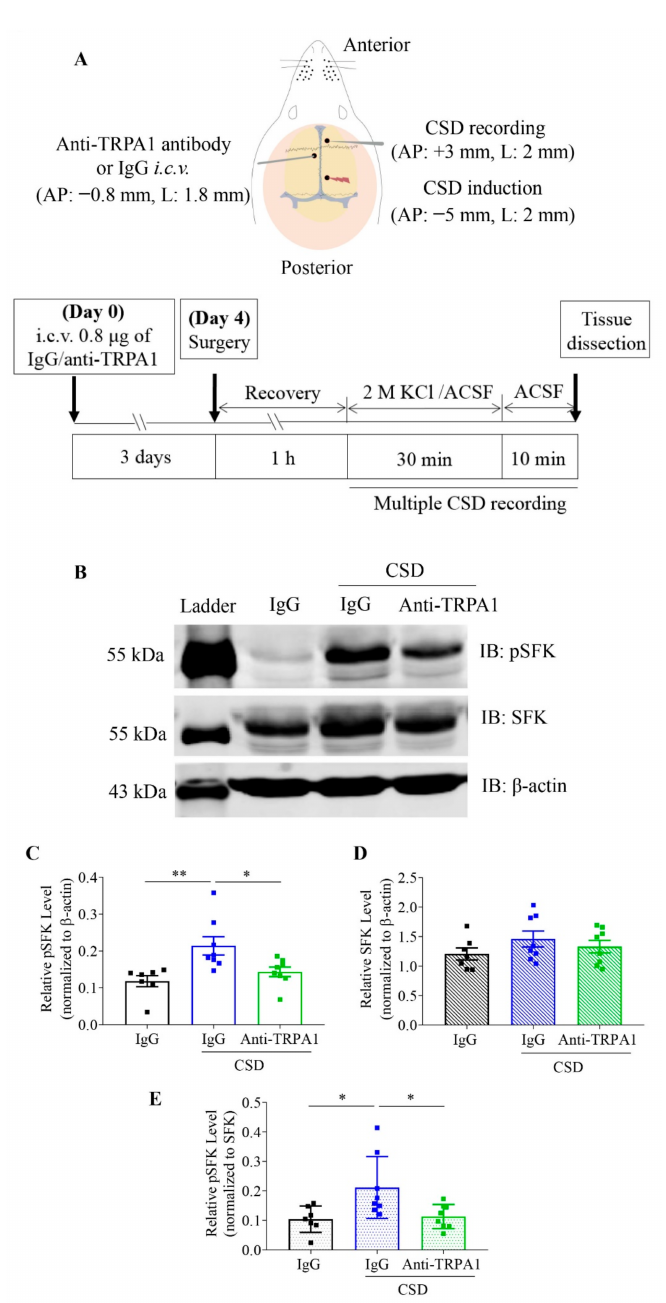
Figure 2. Anti-TRPA1 antibody reduced phosphorylation of SFKs at Y416 induced by multiple CSD in cytosols of rat cerebral cortices. ( A ) Diagram showing brain coordinates for CSD induction, CSD recording and drug perfusion (Upper) as well as the in vivo experimental procedure (lower). ( B ) Representative images showing Western blot analysis of expression of phosphorylated SFKs (pSFKs) at Y416, SFKs and β -actin in cytosolic cerebral cortices of rats treated with IgG or anti-TRPA1 antibody (Anti-TRPA1) at 0.8 µ g with or without 2 M K + -induced CSD. ( C , D ) Data analysis of the levels of phosphorylated SFKs at Y416 or SFKs relative to that of β -actin (absolute ratio in band intensity) and ( E ) comparison of relative pSFK normalized to SFK levels (absolute ratio in band intensity) in cytosolic cerebral cortices of rats treated with IgG without CSD induction ( n = 7), IgG with CSD induction ( n = 8) or anti-TRPA1 antibody with CSD induction ( n = 8). Group data were presented as mean ± SEM. Two-tailed unpaired t -test was used for comparison between IgG without CSD and IgG with CSD group, IgG with CSD and anti-TRPA1 antibody with CSD group. Significance differences were shown as * p < 0.05, ** p <